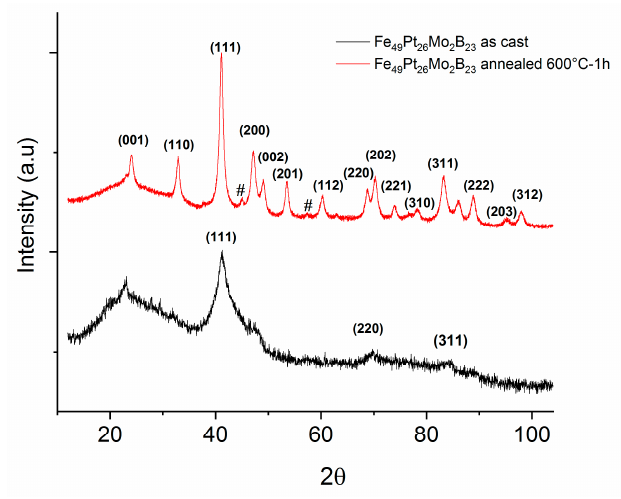
Figure 2. X-ray diffractograms of as-cast and annealed Fe-Pt-Mo-B sample. In the diffractogram obtained for the sample annealed at 600 °C for 1 hour, there are notable differences from the as-cast sample. Several additional Bragg lines are observed,